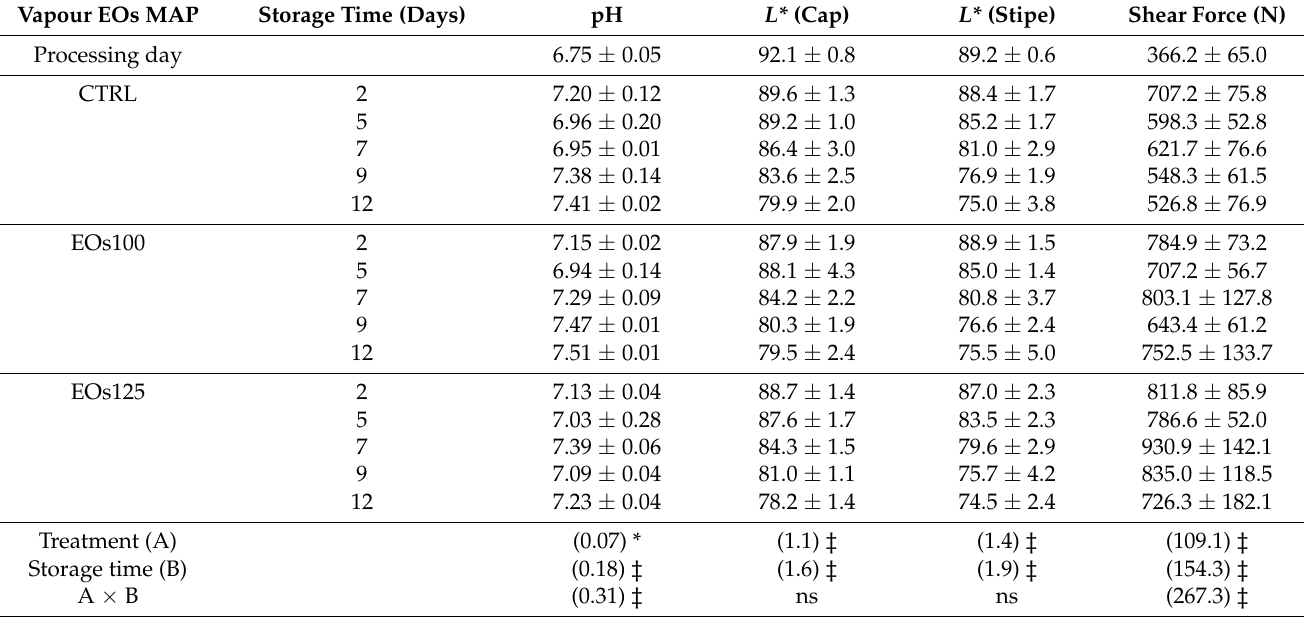
Table 1. pH, firmness (shear force), and colour ( L* ) of sliced mushroom during cold storage (4 ◦ C) under modified atmosphere packaging (MAP) supplemented with vapour essential oils (100 and 125 µ L L − 1 EOs) (mean ± standard devition). Least significant differences are represented within